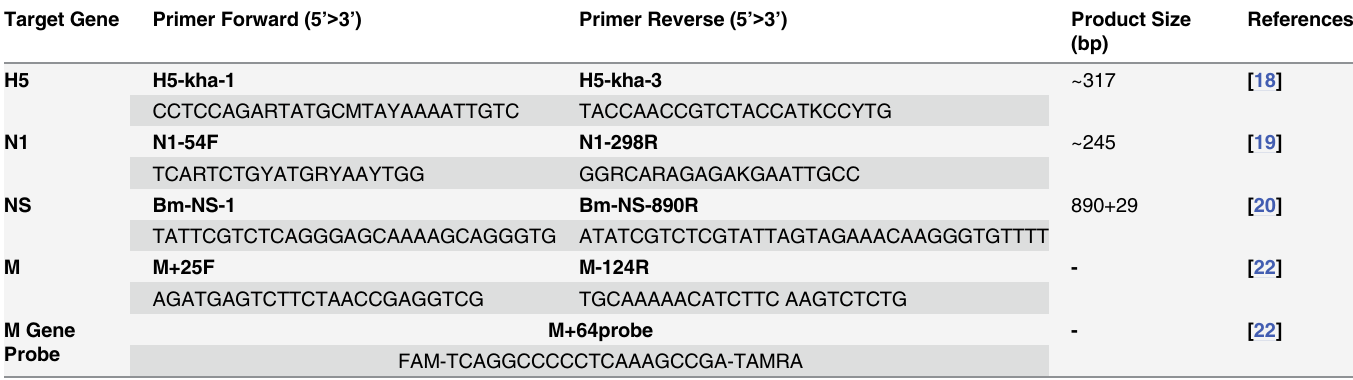
Table 1. Sequences of the Oligonucleotide Primers Used in the Study. Target